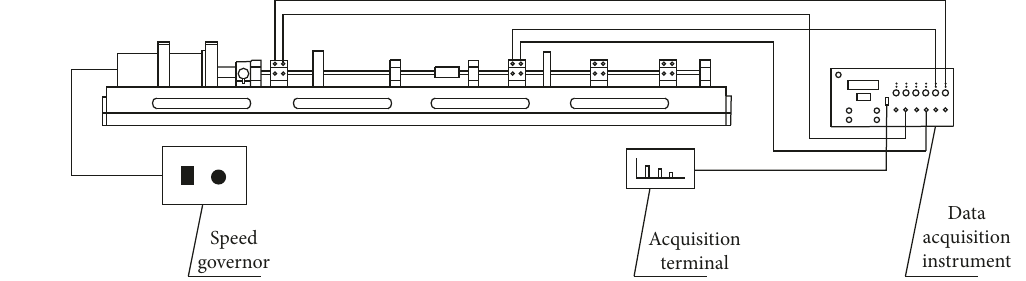
Figure 5: Schematic diagram of the experimental data acquisition system.